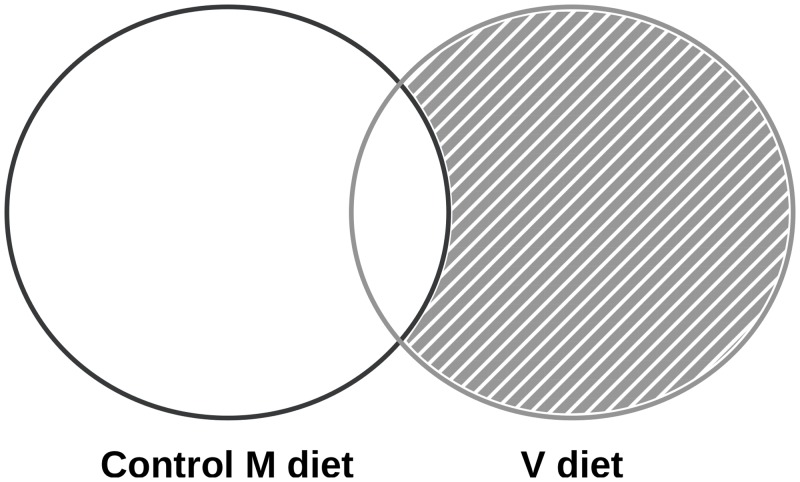
Transcriptomic analysis strategy.Venn diagrams show the numbers of differentially expressed probes (Adjusted P-value < 0.5) when compared the three isogenic lines when fed the control M diet (dark grey) and when fed the V diet (light grey). Probes found to be differentially expressed only with the V diet (V diet ∩ M diet C) were identified as potential molecular markers linked to plant-based diet utilisation, and were thus kept for further analysis (hatched area).